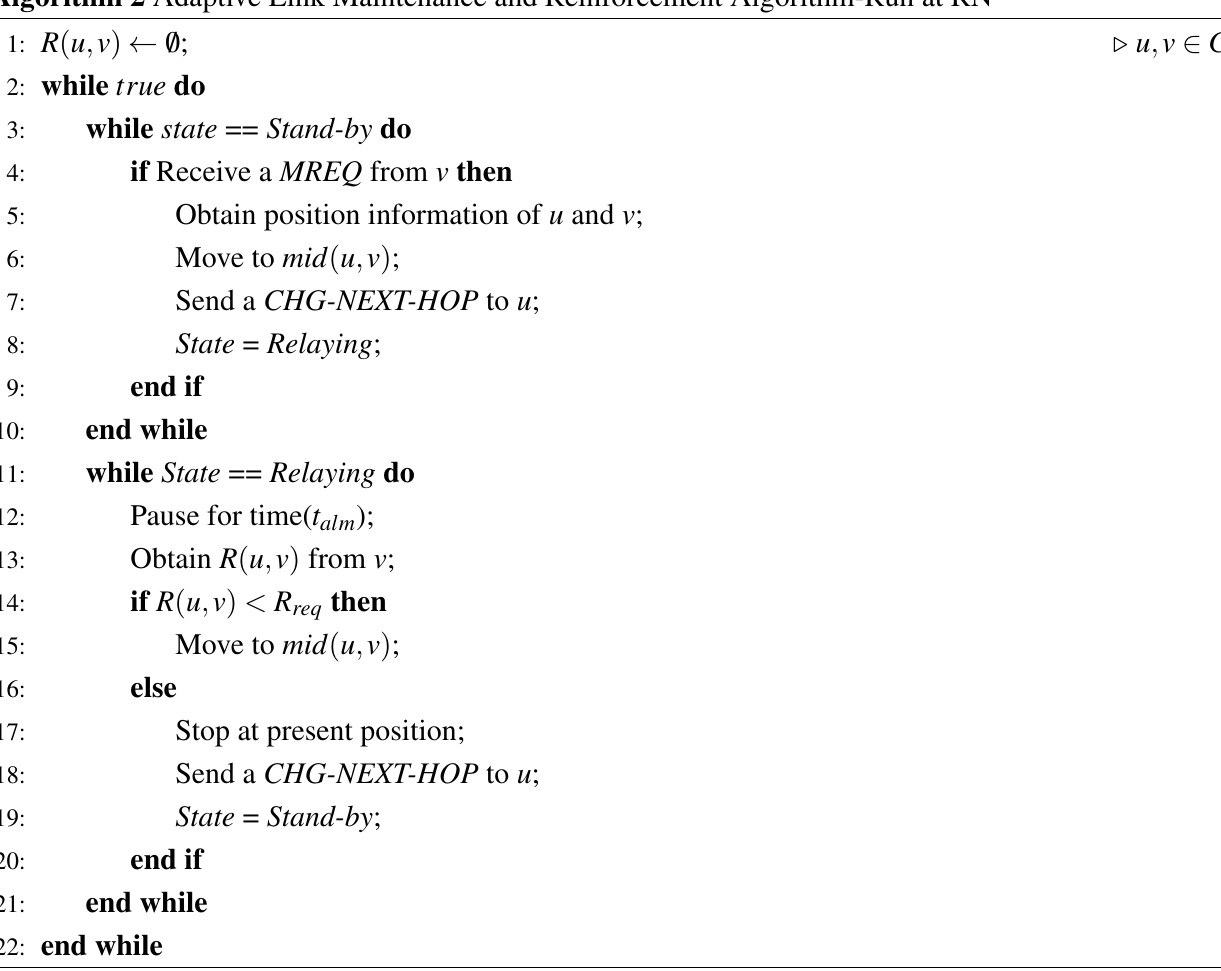
Algorithm 2 Adaptive Link Maintenance and Reinforcement Algorithm-Run at